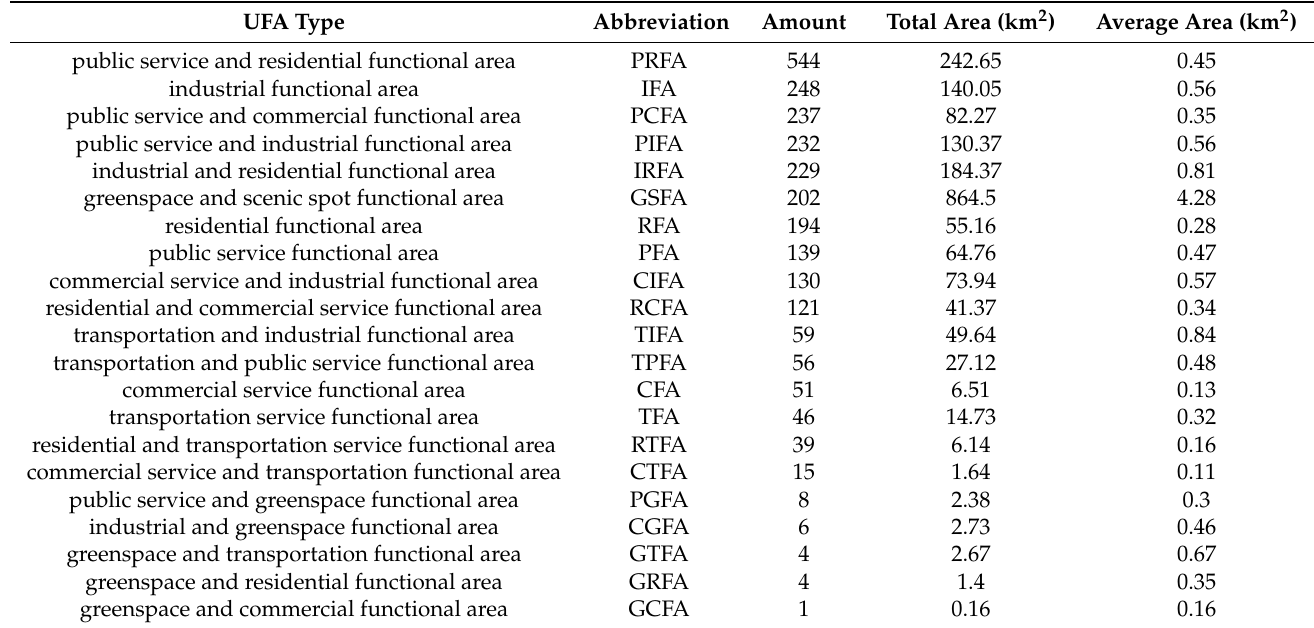
Table 2. The statistics of identification